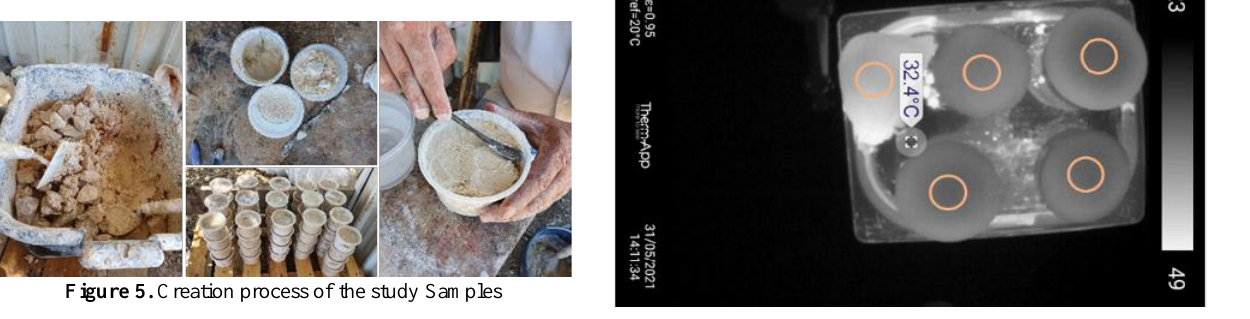
Figure 7. Data recording with